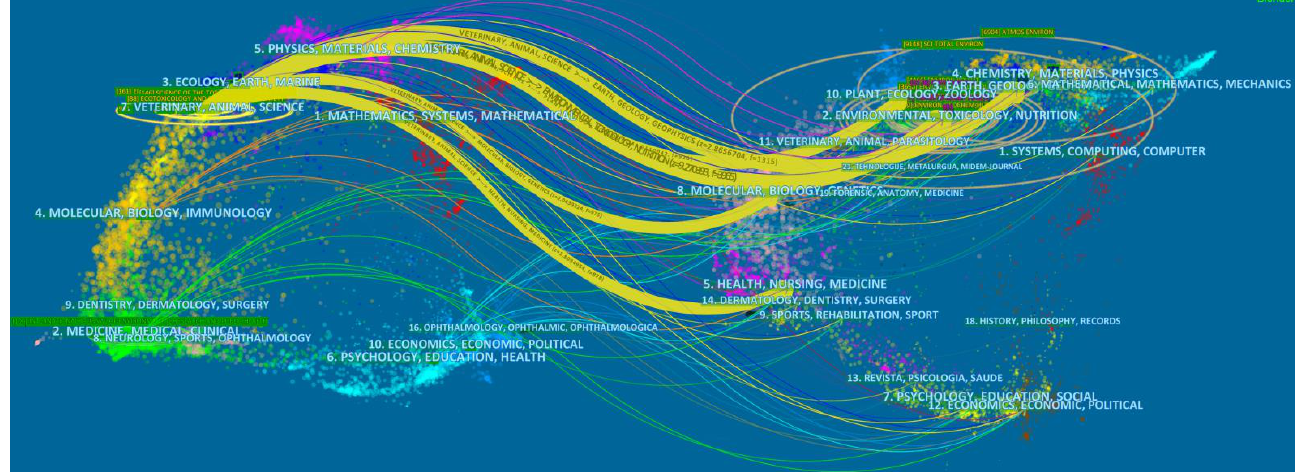
Figure 2. A dual map overlay of literature on urban HIA research.